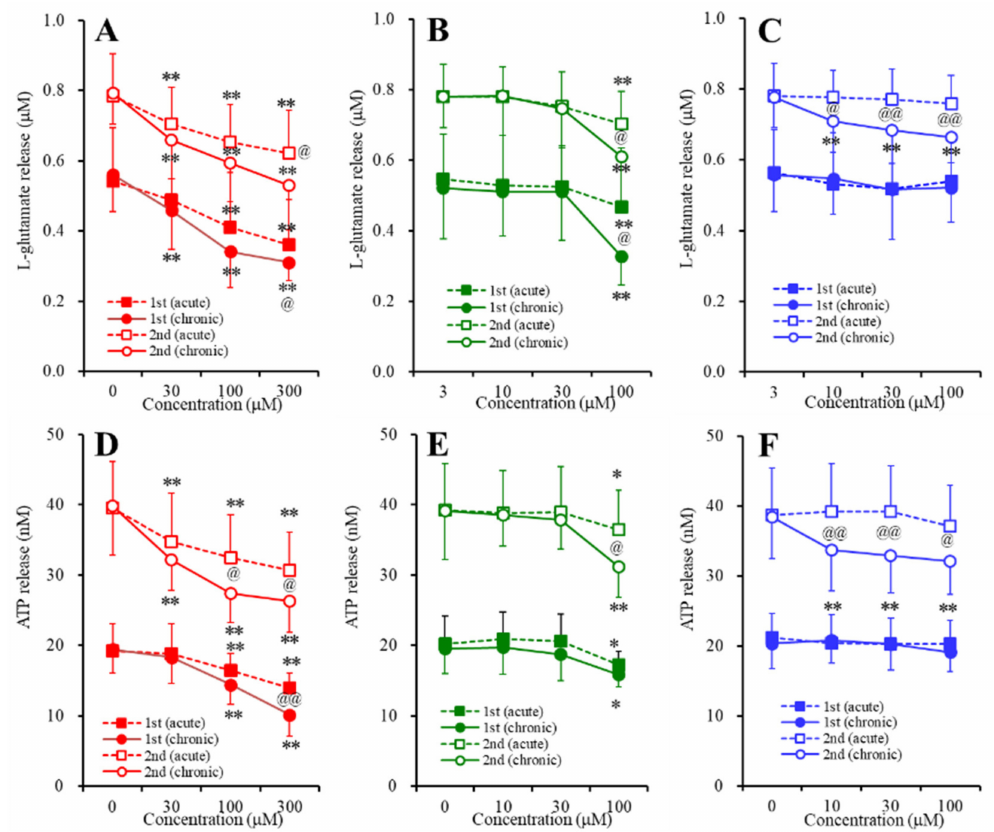
Figure 5. Concentration-dependent e ff ects of the acute (squares) and subchronic (circles) administration of ( A , D ) ZNS (30, 100, or 300 µ M), ( B , E ) CBZ (10, 30, or 100 µ M), and ( C , F ) LCM (10, 30, or 100 µ M) on the repetitive K + -evoked (first: closed marks; second: opened marks) astroglial release of ( A – C ) l -glutamate and ( D – F ) ATP. Ordinate: mean ± SD ( n = 6) of the astroglial release of l -glutamate ( µ M) and ATP (nM). Abscissa: concentration of ZNS, CBZ, and LCM ( µ M). * p < 0.05 and ** p < 0.01 relative to the anticonvulsant-free condition, and @ p < 0.05 and @@ p < 0.01 relative to acute administration